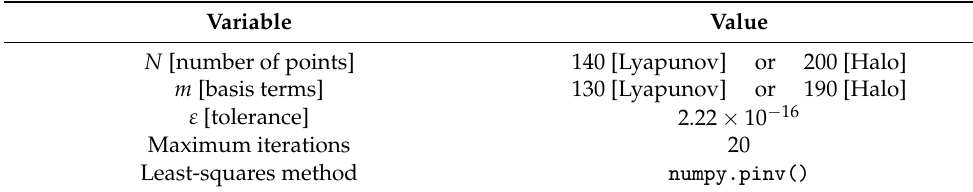
Table 2. TFC algorithm